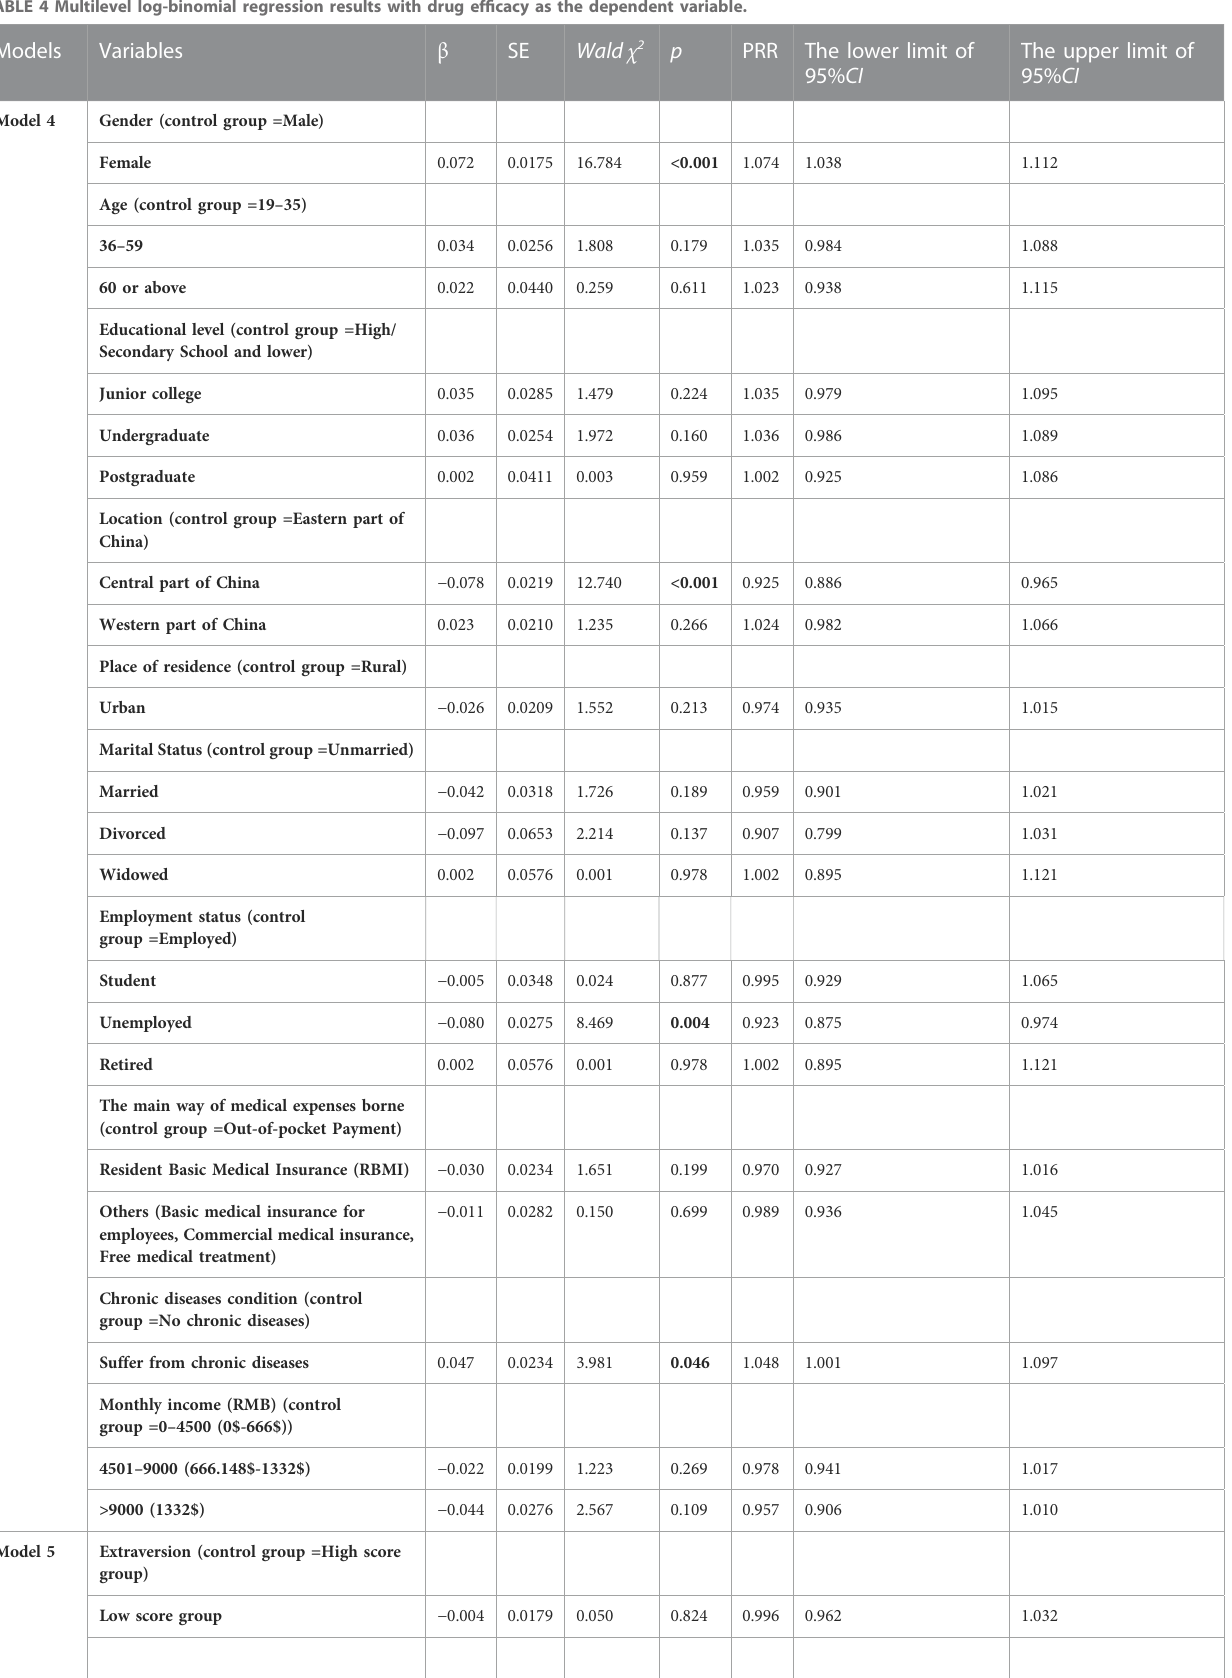
TABLE 4 Multilevel log-binomial regression results with drug ef fi cacy as the dependent variable.